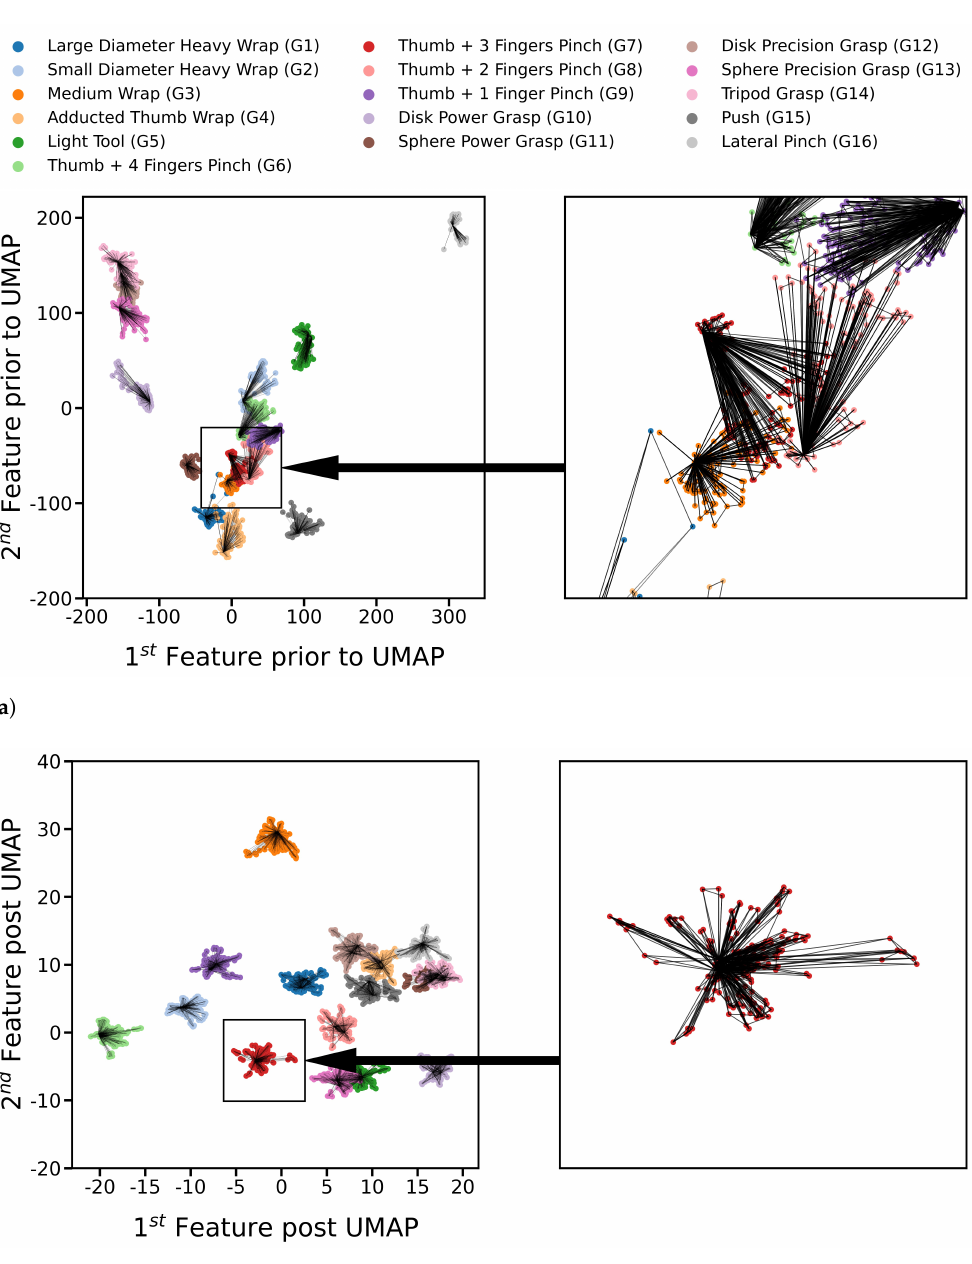
Figure 2. UMAP connections using tuned hyperparameters on participant two training data prior to and post applying UMAP, the final step of the pipeline ( a ) The connections of UMAP visualized on the first and second output features of FDA followed by PCA. The connections of gesture G7 points and their neighborhood are enlarged, showing the classes’ overlap. ( b ) The connections of UMAP visualized on the first and second final output features of the pipeline post applying UMAP. The connections of gesture G7 are enlarged, showing the class separability post applying